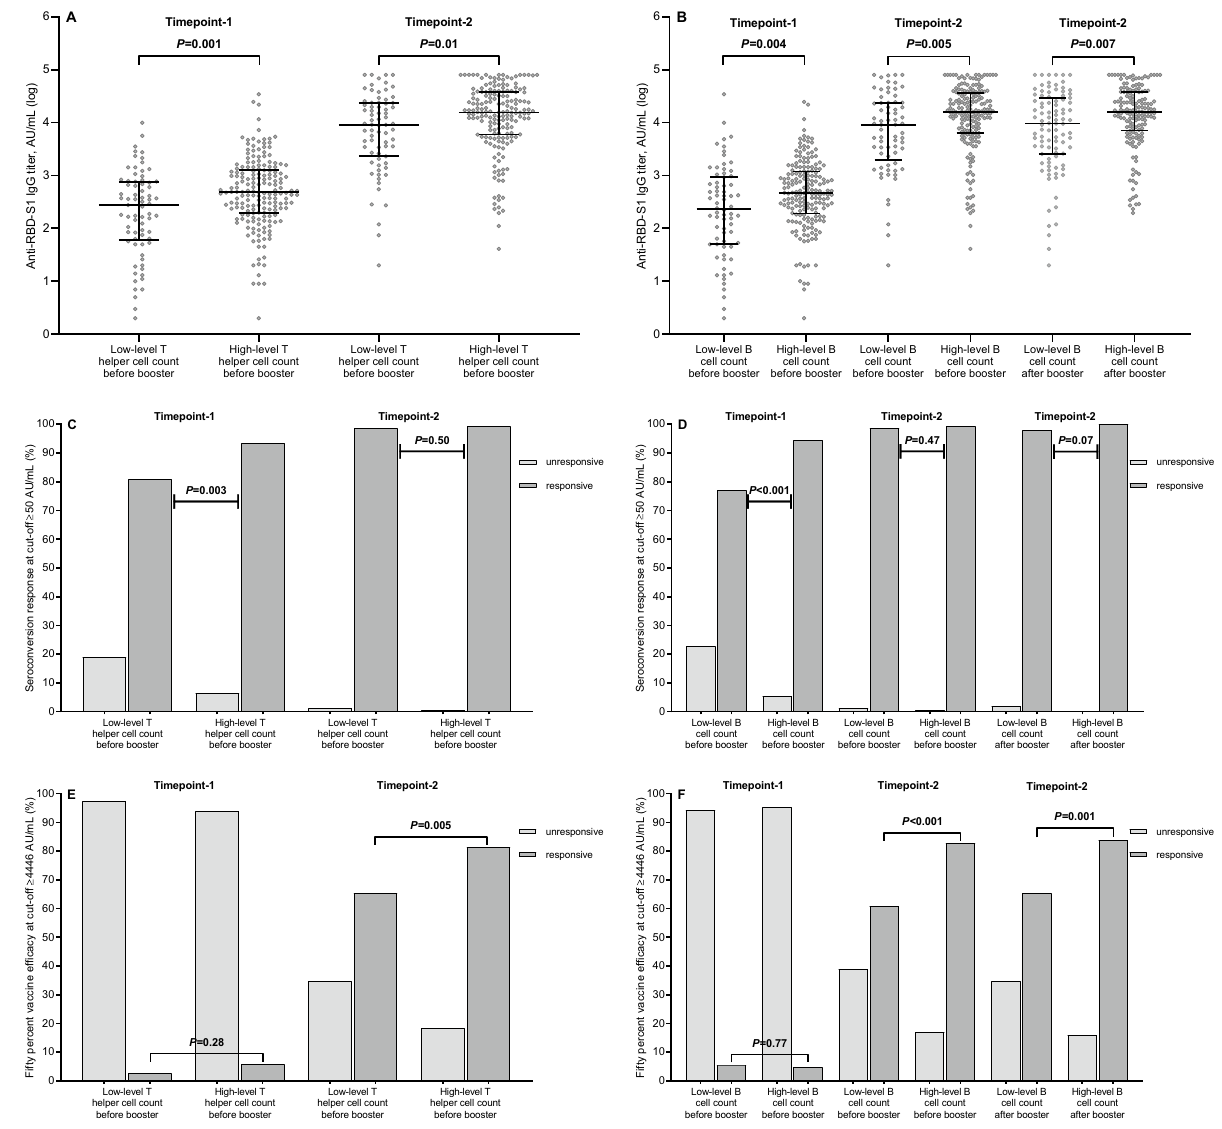
Figure 4. Antibody response by level of lymphocyte subpopulation counts. ( A ) Comparison of scatter plot distributions and medians of antibody titers by level of T helper cell counts. ( B ) Comparison of scatter plot distributions and medians of antibody titers by level of B cell counts. ( C ) Comparison of seroconversion response rates by level of T helper cell counts. ( D ) Comparison of seroconversion response rates by level of B cell counts. ( E ) Comparison of 50% vaccine efficacy rates by level of T helper cell counts. ( F ) Comparison of 50% vaccine efficacy rates by level of B cell counts. Bars represent median values with 95% Confidence Intervals. Differences between groups were assessed using the Mann–Whitney U test (continuous variable) or the Pearson’s χ 2 test (categorical variables), as appropriate. A two-sided P value of < 0.05 was considered statistically significant. RBD-S1, receptor-binding domain (RBD) of the SARS-CoV-2 Spike protein (S1); AU, Arbitrary Unit; log, logarithmic values. Timepoint-1 denotes assessment before the third dose of tozinameran; Timepoint-2 denotes assessment four weeks after the third dose of tozinameran; an antibody titer ≥ 50 AU/ mL indicates a positive seroconversion response; antibody titer ≥ 4446 AU/ml was associated with 50% vaccine efficacy against a symptomatic COVID-19